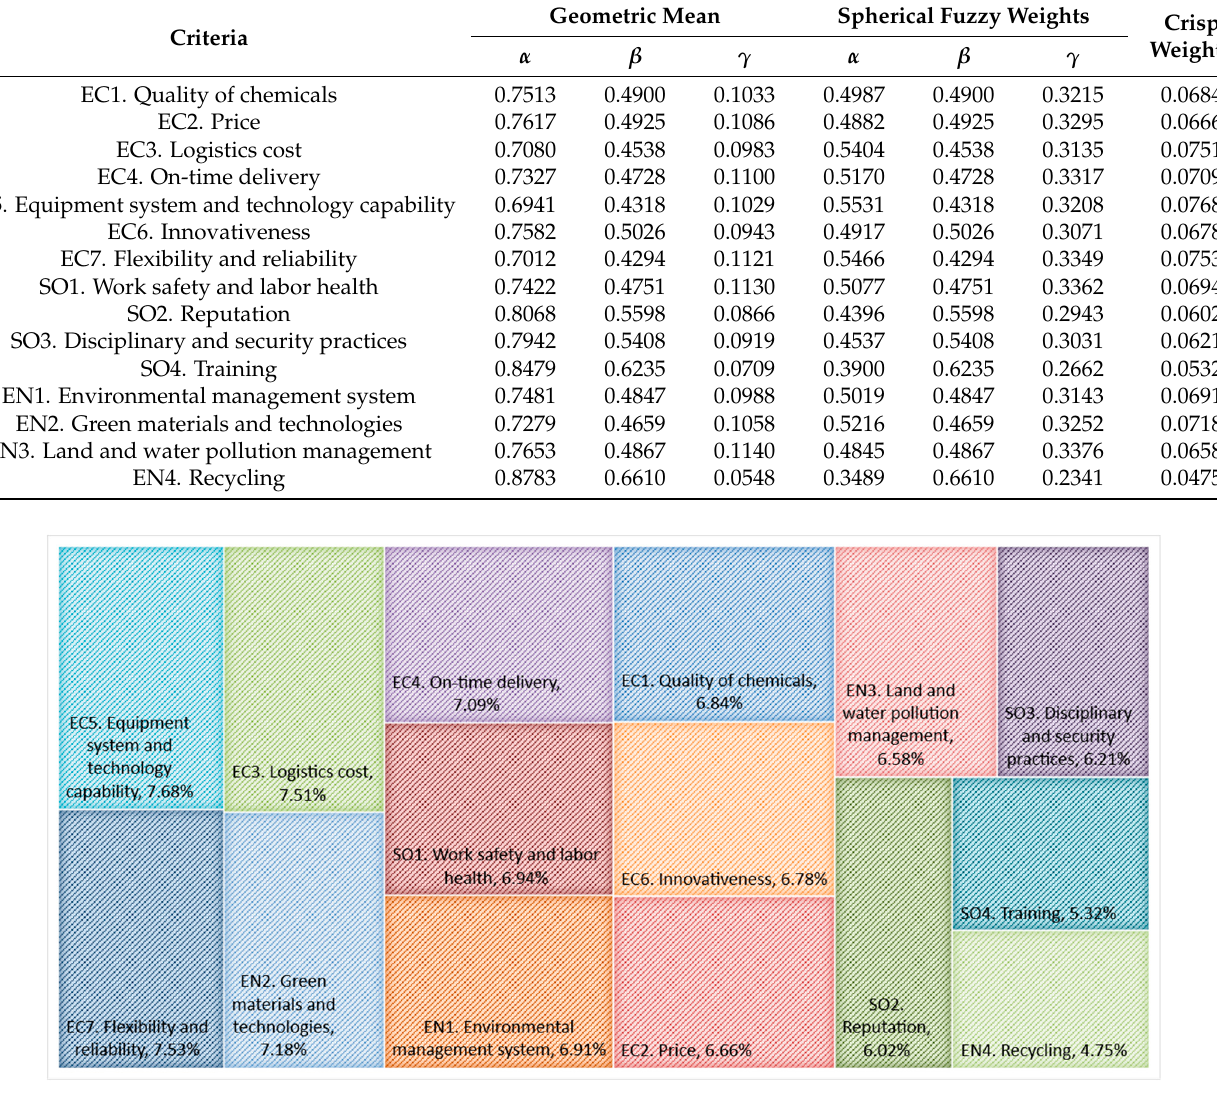
Figure 3. The significance levels of 15 criteria of SF-AHP.